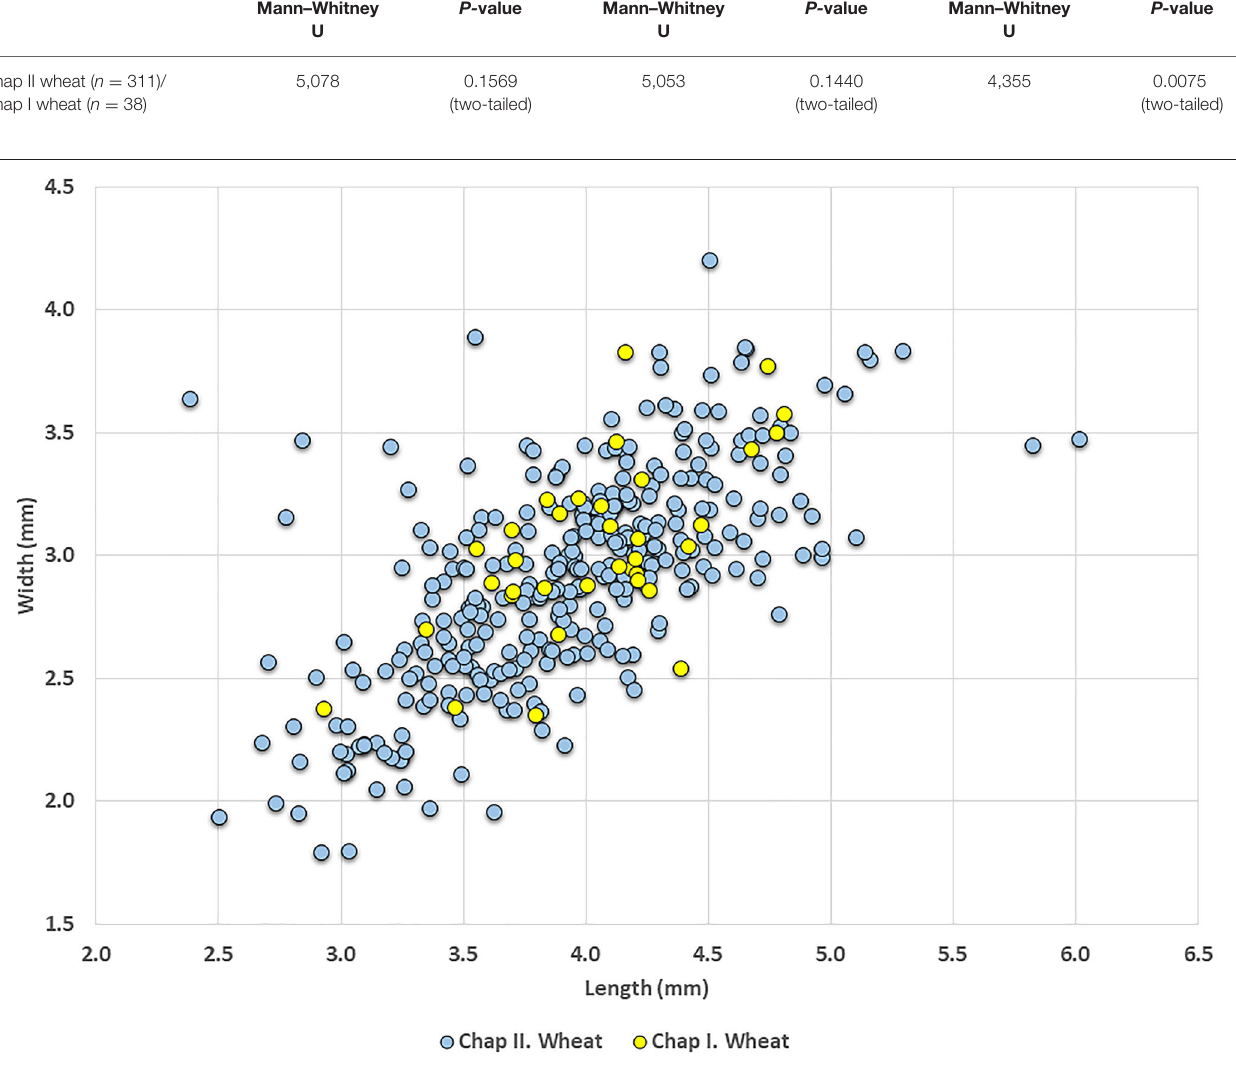
FIGURE 4 | A scatter plot: Chap I vs. Chap II wheat. along the mountain/steppe ecotone in the Tien Shan Mountains of eastern Kazakhstan (Spengler, 2013). While the small sample size from Tseganka may bias the interpretation, the grains were longer, wider, and more compact (L/W =